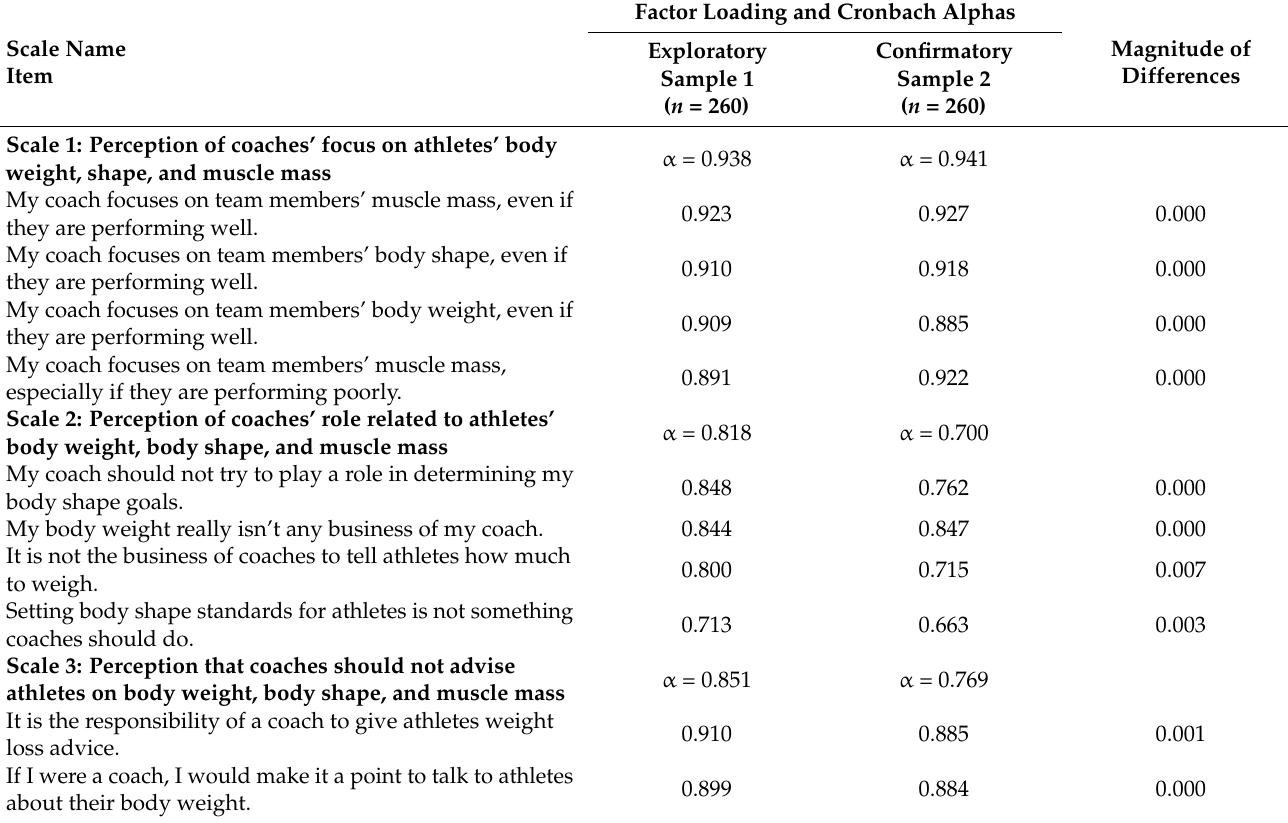
Table 4. Exploratory and Confirmatory Factor Loadings and Magnitude of Differences for Male Responses to Athletes’ Perceived Body Pressures from Coaches Questionnaire.